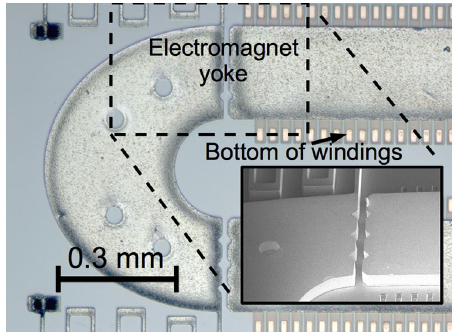
FIG. 12. Photograph of a MEMS microactuator during fabri- cation demonstrating results of the magnetic yoke electroplating process step. The inset shows a scanning electron micrograph of the pictured microactuator at a 45 (cid:8)